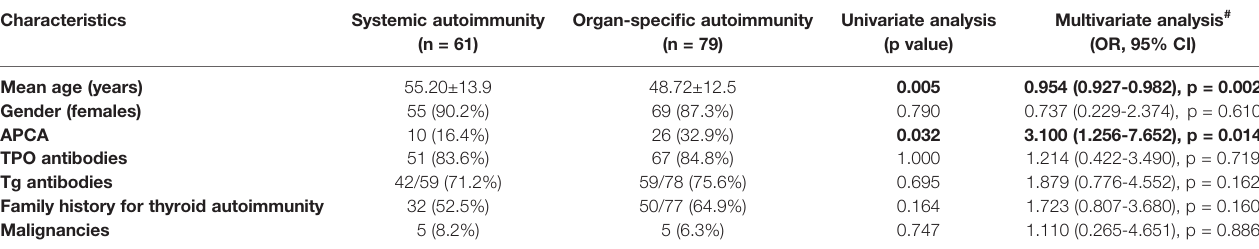
TABLE 2 | Univariate and multivariate analysis of factors associated with organ-speci fi c and systemic autoimmunity in HT patients (n = 140).